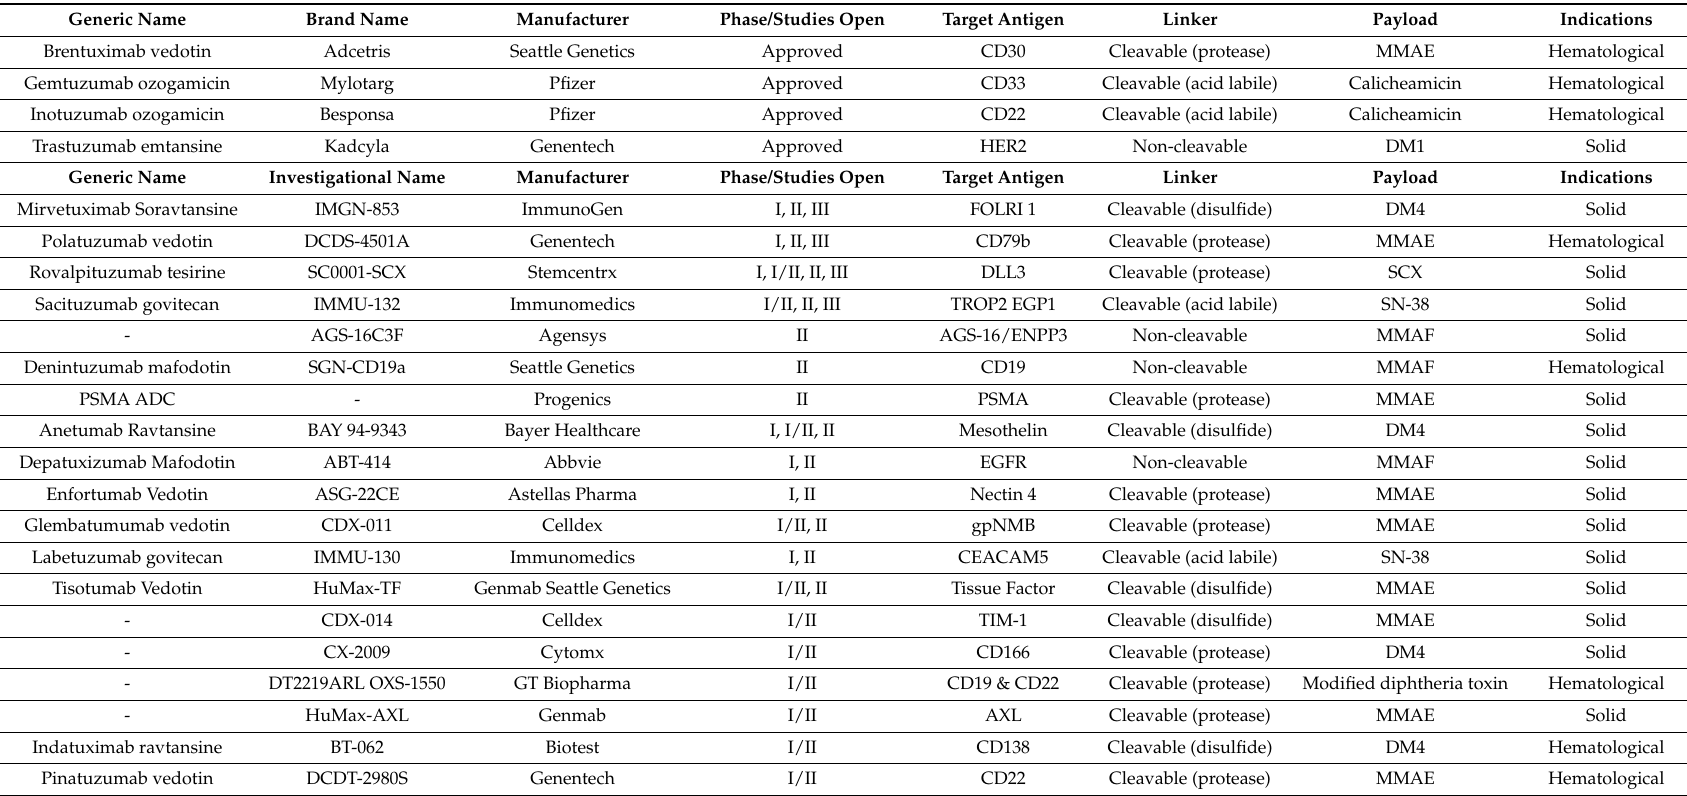
Cleavable (protease) MMAE